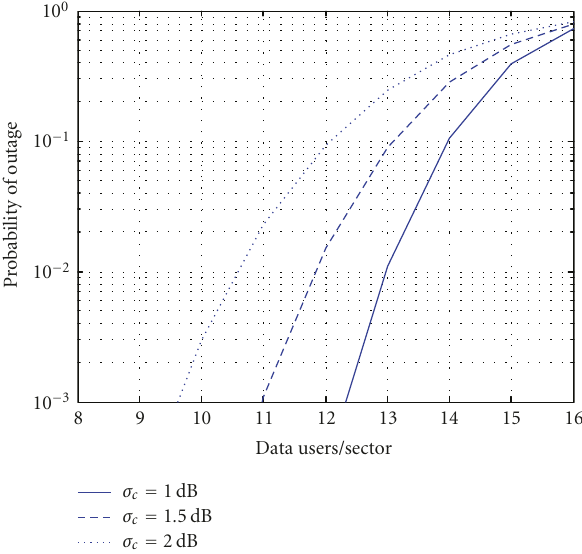
Figure 5: Outage probability of the sector for data users